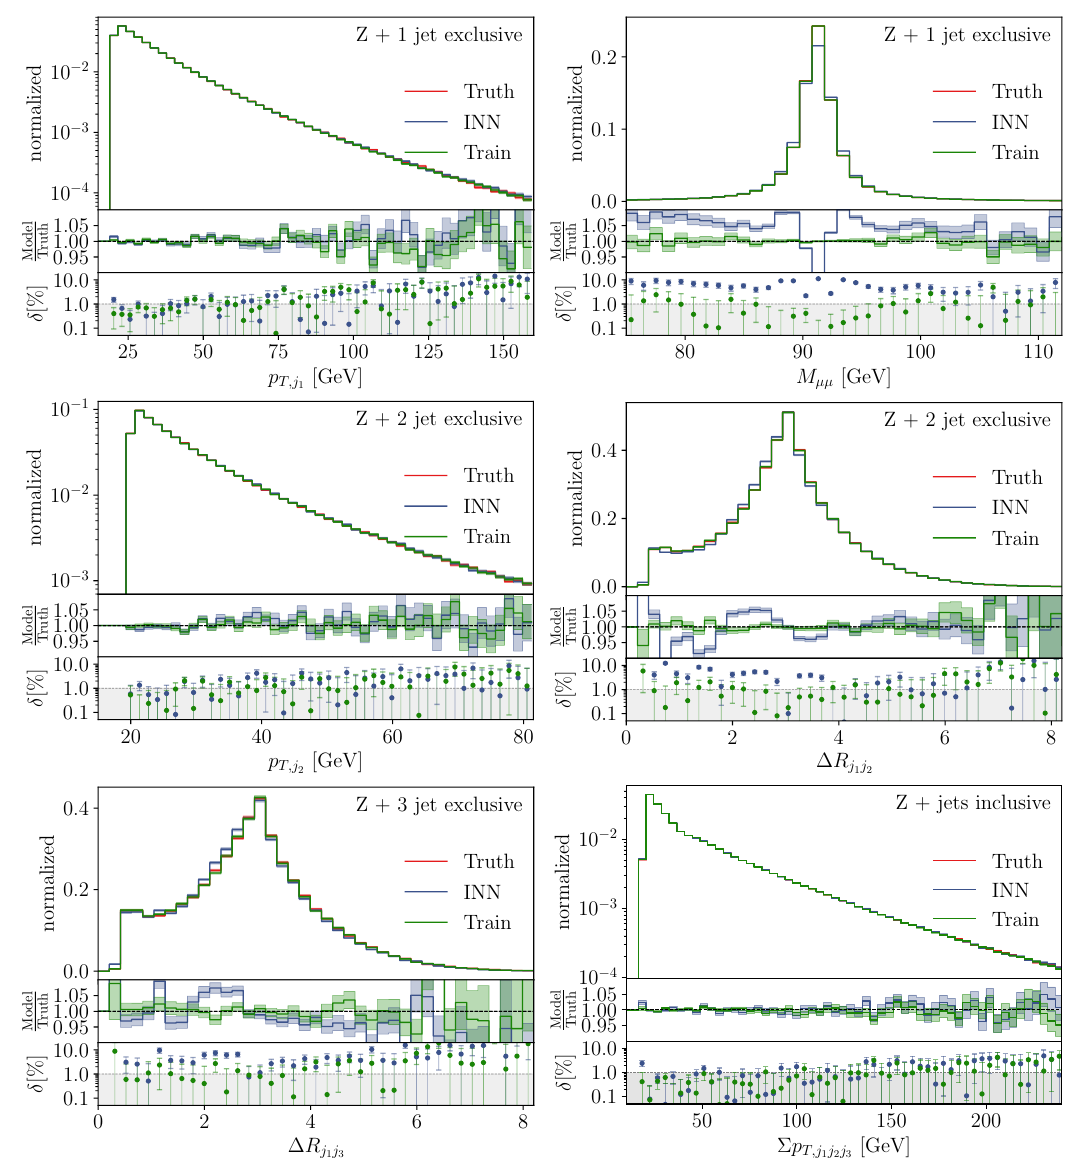
Figure 4: INN distributions for Z + 1 jet (upper), Z + 2 jets (middle), Z + 3 jets (lower left) and an inclusive distribution (lower right) from a combined Z + jets